Question: Give a one-sentence summary of this figure.
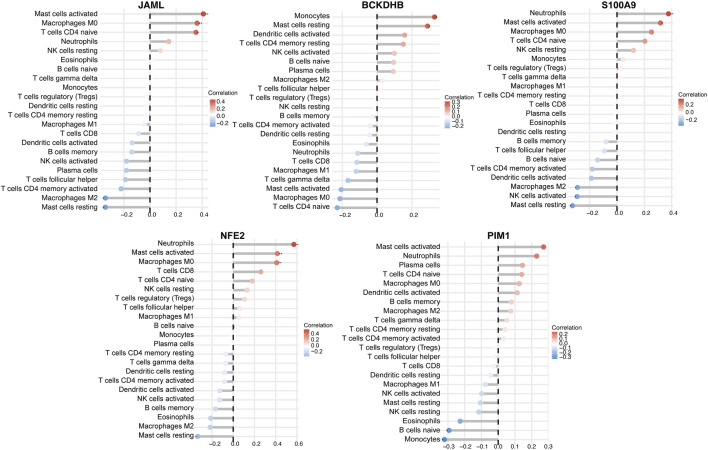
Answer: Correlation analysis between feature genes and gene–immune infiltration in PAD.